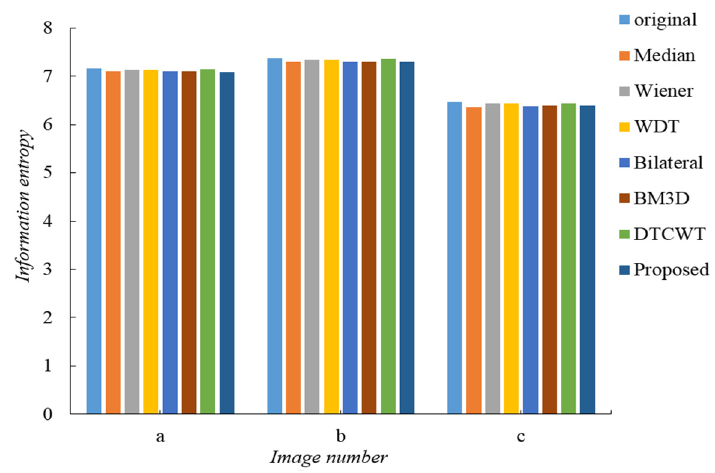
Figure 22. Information entropy of images using different methods.